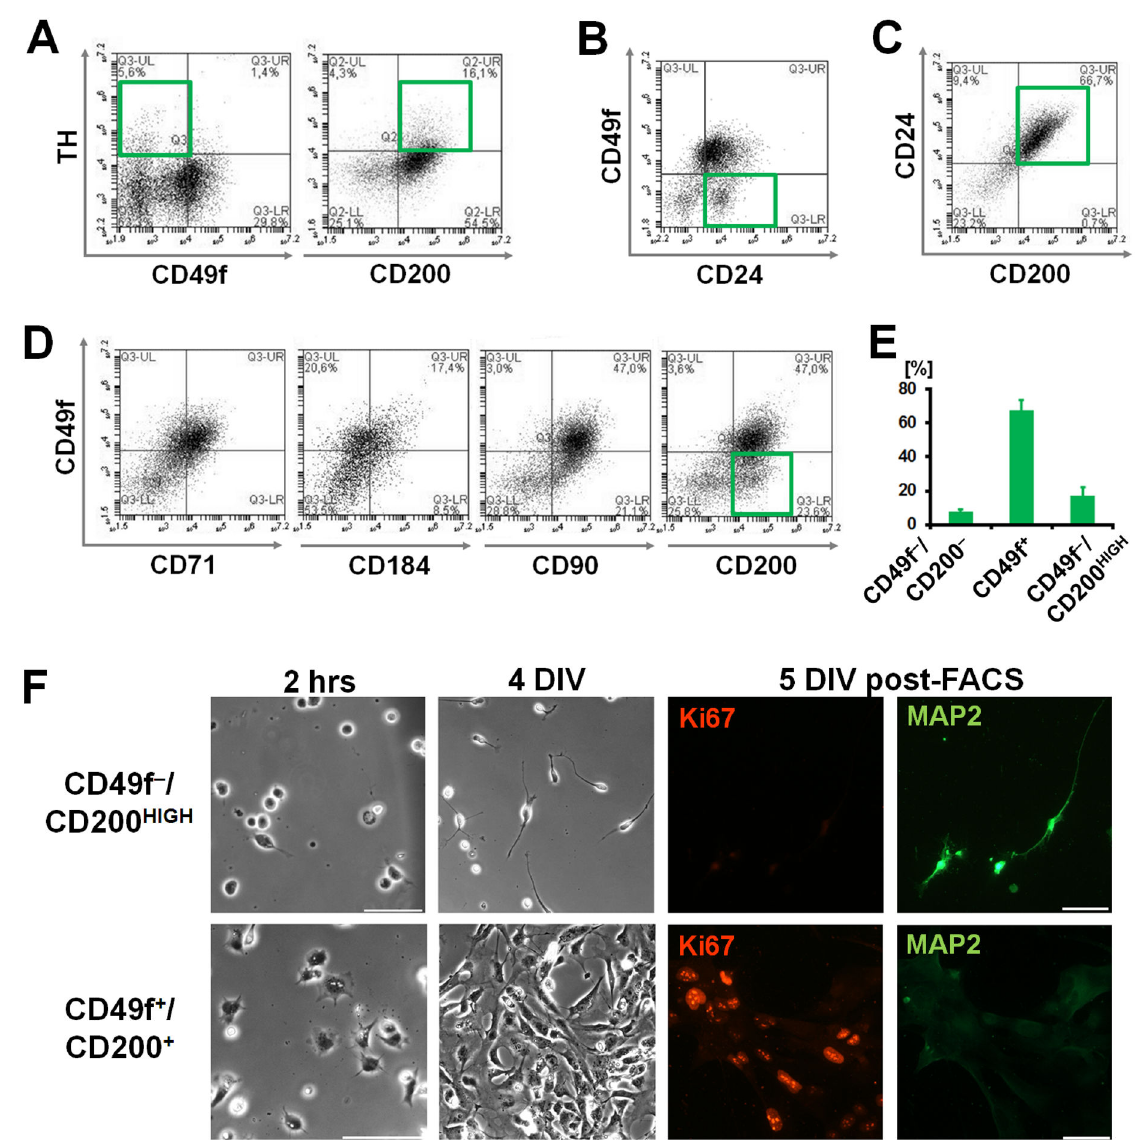
Figure 8. Application for neural cell isolation in human iPS cells. ( A ) Flow cytometric analysis of the intracellular neuronal subpopulation marker tyrosine hydroxylase (TH) with surface marker candidates CD49f and CD200 (on fixed and permeabilized hiPS-NSC). ( B , C ) Co-expression analysis of CD49f and CD200 with the established neural marker CD24. ( D ) Co-expression analysis of CD49f with CD71, CD184, CD90, CD200 antigens. Note occurrence of CD49f-negative subset with CD200 co-labeling (green rectangular gate). ( E ) Presence of CD49f/CD200 subpopulations in hiPS-NSC differentiation (four independent experimental lines). ( F ) Phase contrast and immunofluorescence imaging post-FACS; hiPS-NSC at 2 hours, DIV 4 and 5 after CD49f/CD200 FACS. [Scale bars: 50µm. Panels B to D on live hiPS-NSC suspensions without fixation and permeabilization].